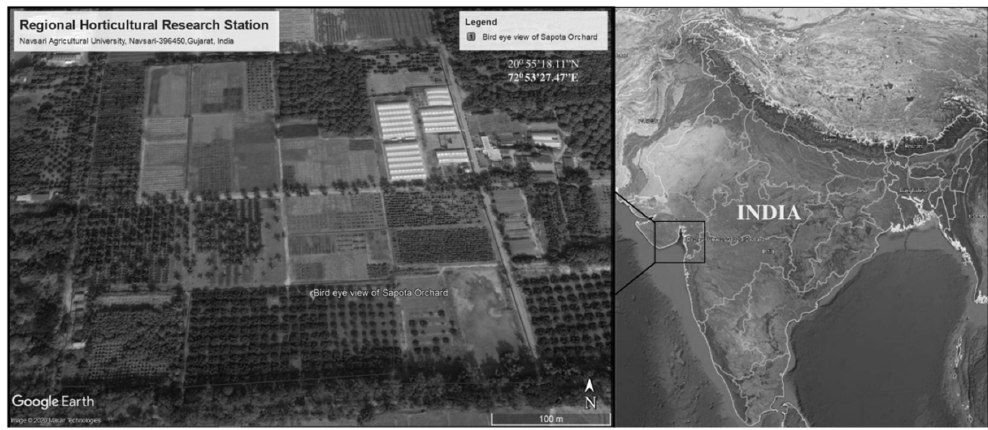
Figure 2. Map of the Sapota fruit and soil sampling